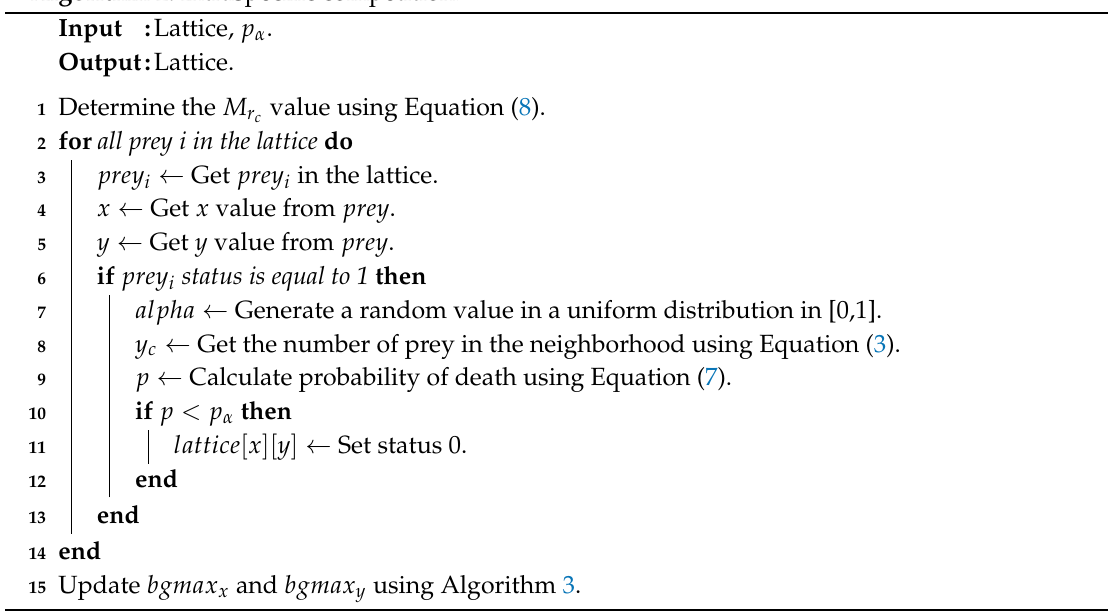
Algorithm 2: Intraspecific competition.